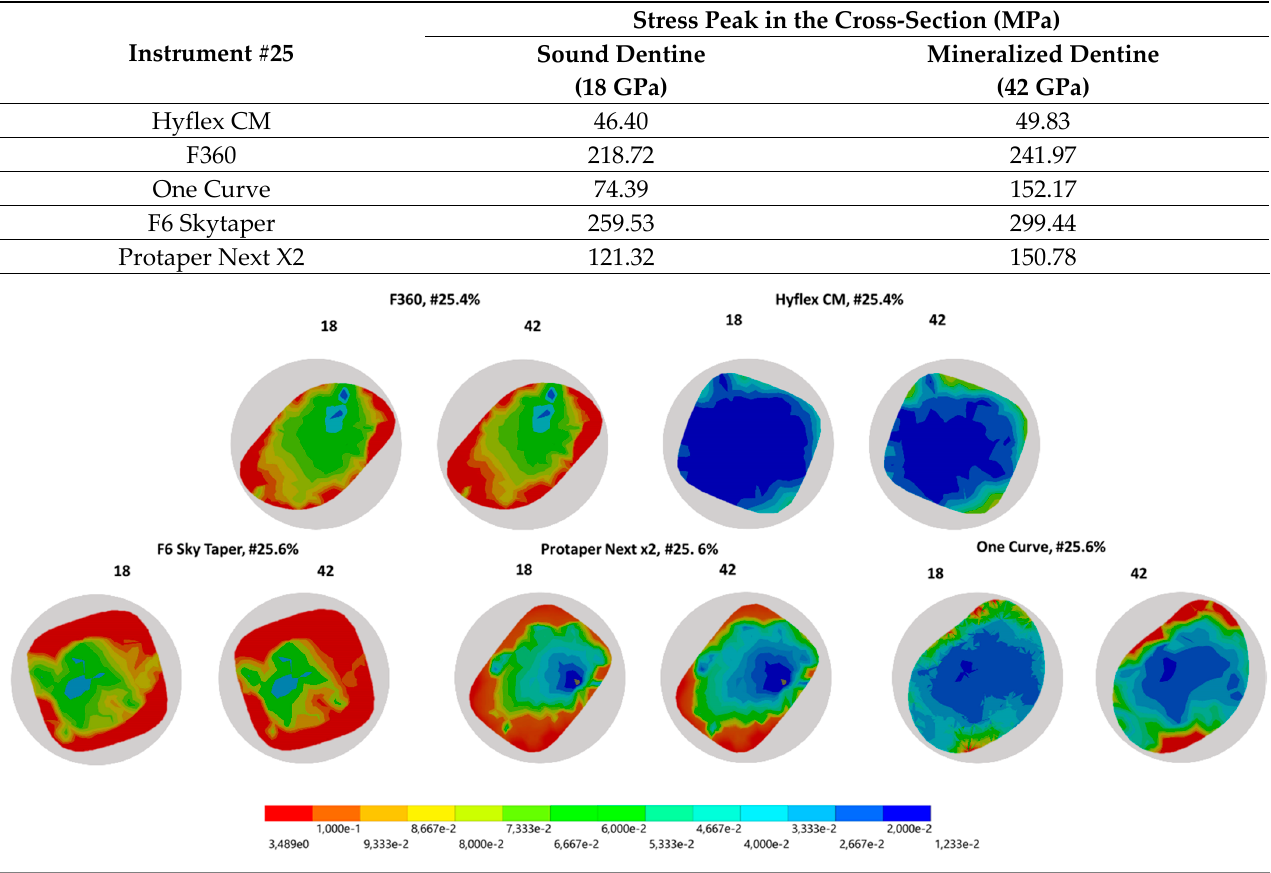
Figure 6. The highest von Mises stress peaks in the cross section (MPa) for each instrument according to the elastic modulus of the root dentine canal (18 or 42 GPa) are depicted. The external surface of the instrument resulted with higher stress (red area), the internal area relatively free from stress (blue color): numerically different values area reported. Interestingly, Hyflex CM was free from high stress area both in surface and in deeper area of instrument section.